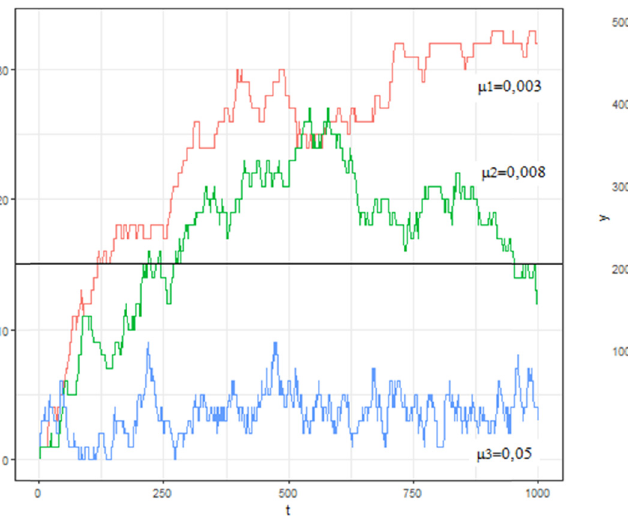
Figure 4: Simulation of times for the parameters of the